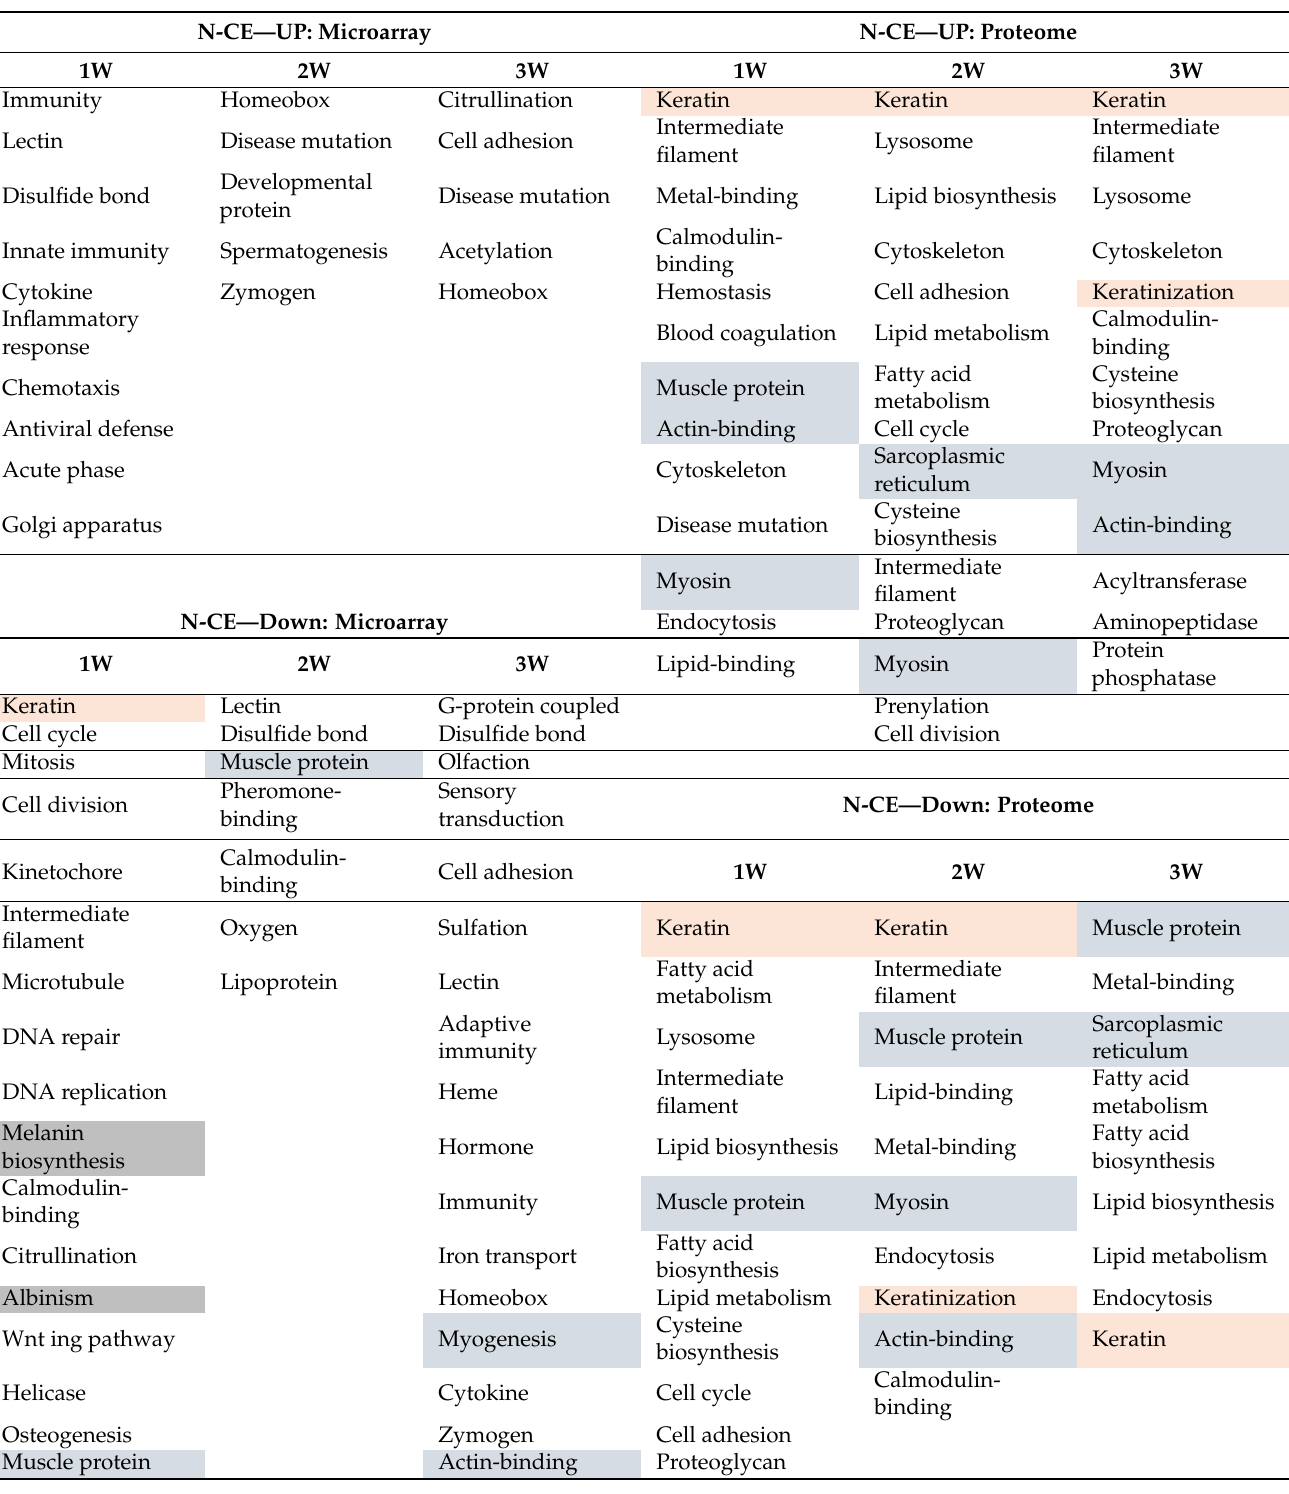
Table 6. A biofunctional categorization and pathway of the identified genes and proteins in the N-CE group 1 week, 2 weeks, and 3 weeks after treatment. Both the up- and down-regulated terms for genes and proteins were displayed together for comparison. DNA microarray and proteomics and DAVID analyses were performed as described in the Section